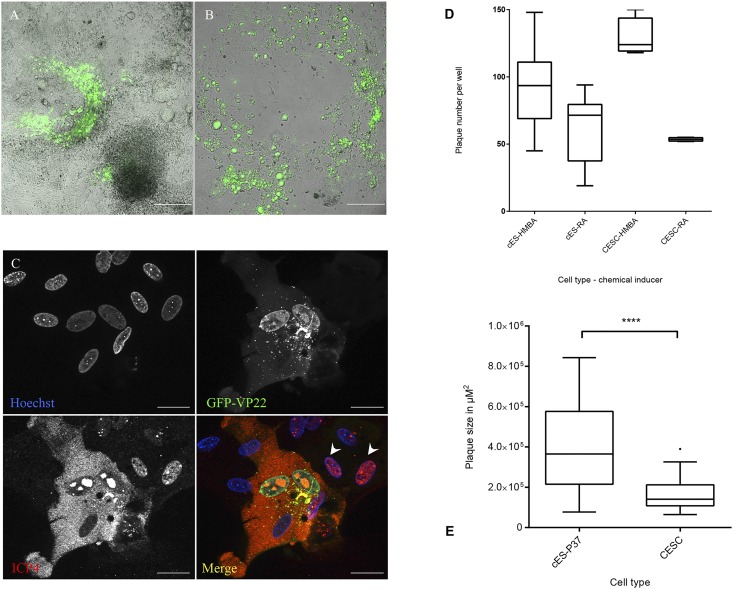
Differentiation increases permissiveness of cES to GaHV-2.(A & B): cES cells were plated and infected 6 days post plating in reduced serum conditions with sorted CESC infected with vBAC20GFPVP22. Cells were fixed after an incubation of 6 days at 37°C. (A) cell monolayers were maintained in WE medium containing 1% FBS and 1.5% CS. (B) DMSO (64 μM) was added from day 4 after plating and until the end of the culture (scale bar represents 200 μm). (C) cES cells (passage 36) were exposed to HMBA and infected with sorted vBAC20GFPVP22-infected cells. Expression of VP22 was detected by the GFP signal and ICP4 by staining with monoclonal antibody E21 (red); cell nuclei were stained by Hoechst 33342. At late stages of infection, ICP4 is detected both in the cytoplasm and nucleus in VP22 expressing cells. At early stages of infection, when VP22 is barely detectable in the cells surrounding the highly infected cell, ICP4 staining is predominantly nuclear (arrow heads) indicating spread of virus from the originally infected cell to the neighbouring cells (scale bar represents 20 μm). (D) Induction of differentiation by HMBA increases susceptibility of cES cells to GaHV-2 infection. Comparison of the plaque counts at 4 days pi either on cES cells or on primary CESC exposed to differentiating drugs (2 independent experiments sampling 10 replicates for each condition with cES and 4 replicates with CESC). (E) Comparison of plaque sizes on either cES exposed to HMBA differentiation or CESC. For both cell types, HMBA was added in the maintenance medium after the infection with sorted vBAC20EGFPVP22-infected cells. Plaques appeared larger in cES differentiated cells. Plaque sizes from 80 plaques per experiment are shown as boxplots and whiskers (Tukey) (in B, P<0.001; Mann Whitney test).